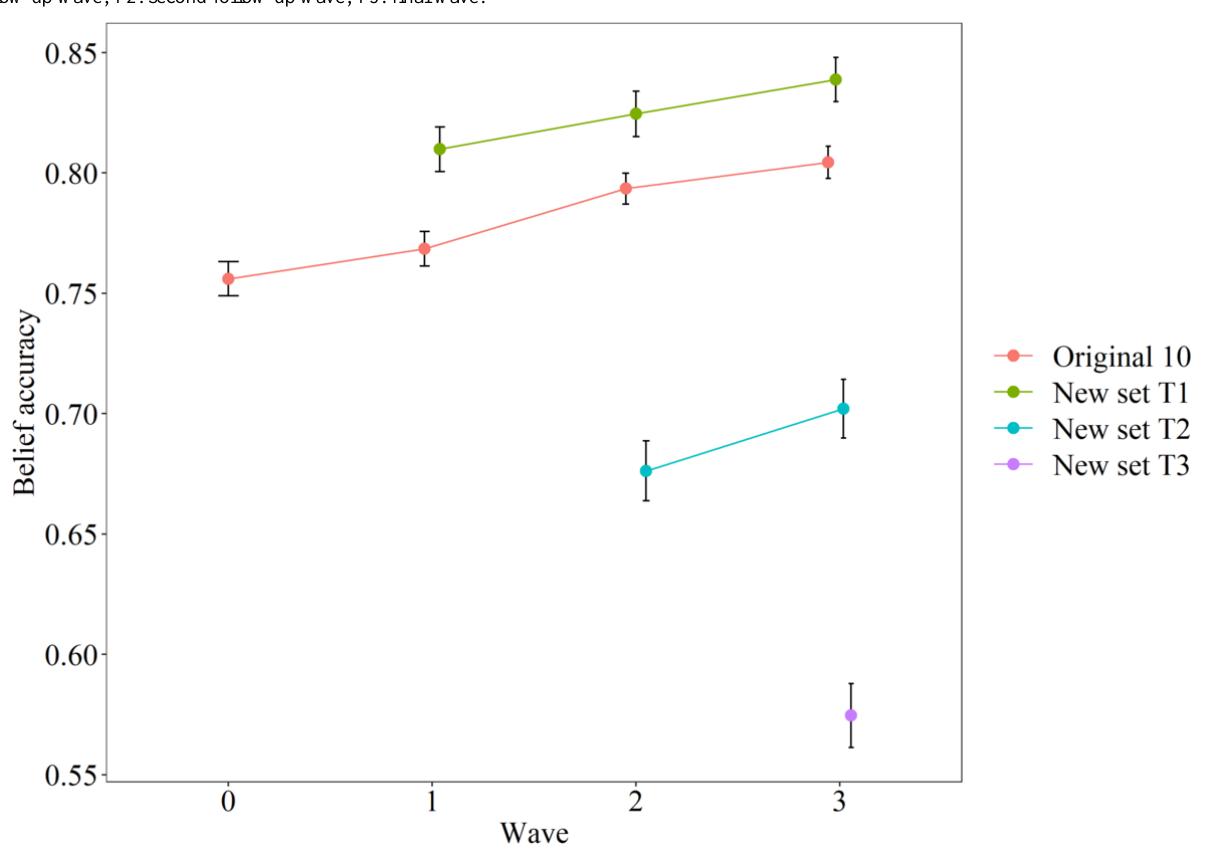
Figure 2. Belief accuracy per set of statements over time. The new set at T3 was included for completeness. Focusing on within-subject change, dots represent normed means and error bars indicate 95% CIs of the within-subject SE [34], calculated using the summarySEwithin function from the Rmisc package [35]. The belief accuracy scale ranged from –1, indicating completely inaccurate beliefs, to 1, indicating completely accurate beliefs. T1: first follow-up wave; T2: second follow-up wave; T3: final